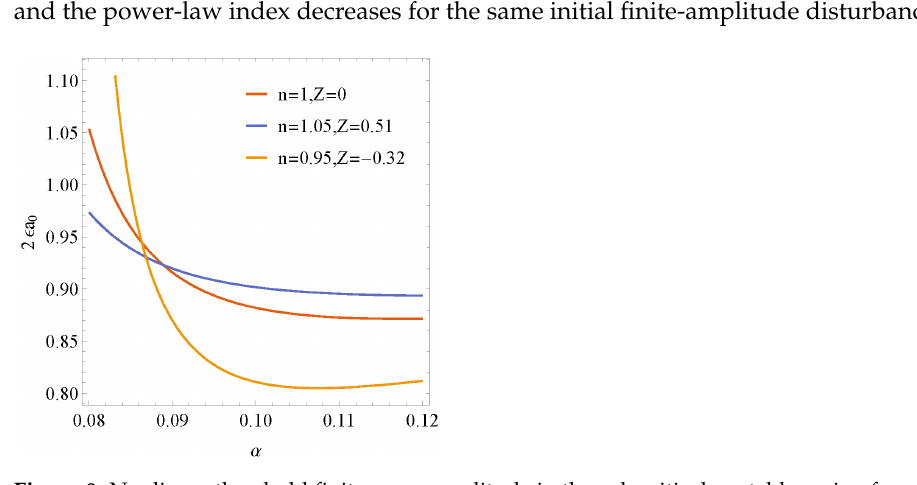
12 of 15 Figure 7. Nonlinear neutral stability curves of the film flow for various α and Re at n = 0.95, Z = − 0.32. Figure 8 shows how the nonlinear threshold amplitude at Re = 5 will be affected by